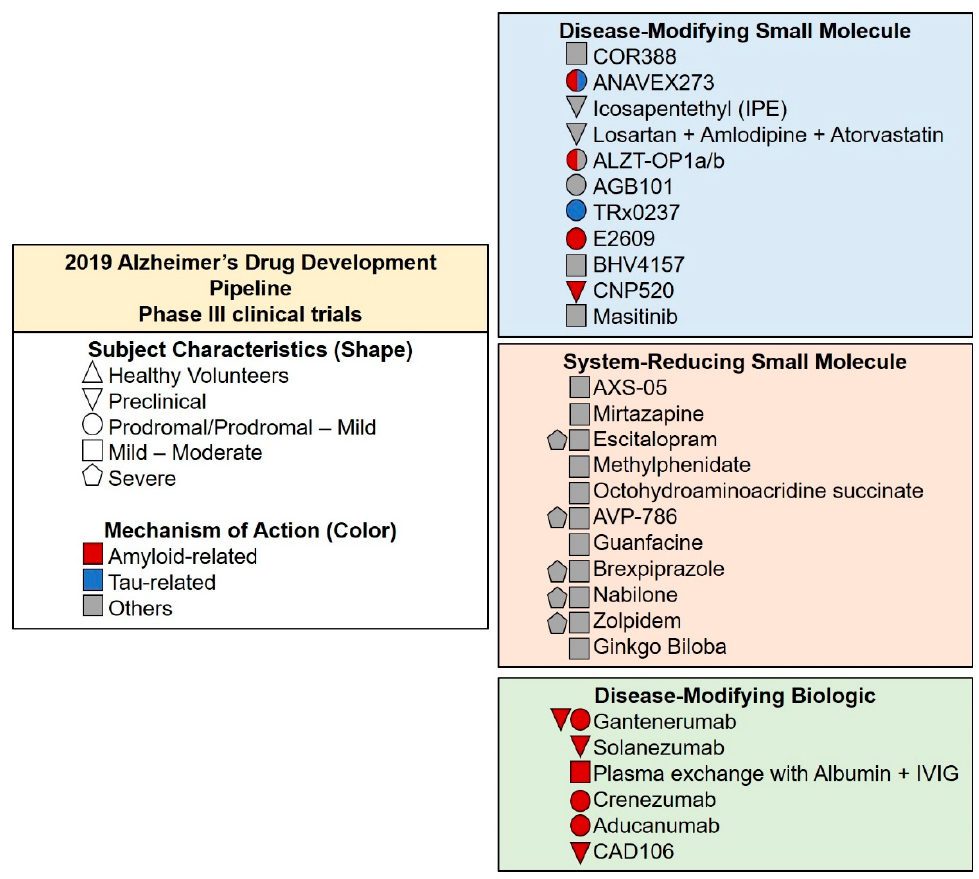
Figure 4. Compounds in phase III clinical trials in 2019, classified by mechanism of action. The agents in green are biologic, in blue are small molecules, and in orange are symptomatic agents designed to treat AD associated symptoms or cognitive enhancement. Adapted from [23] .